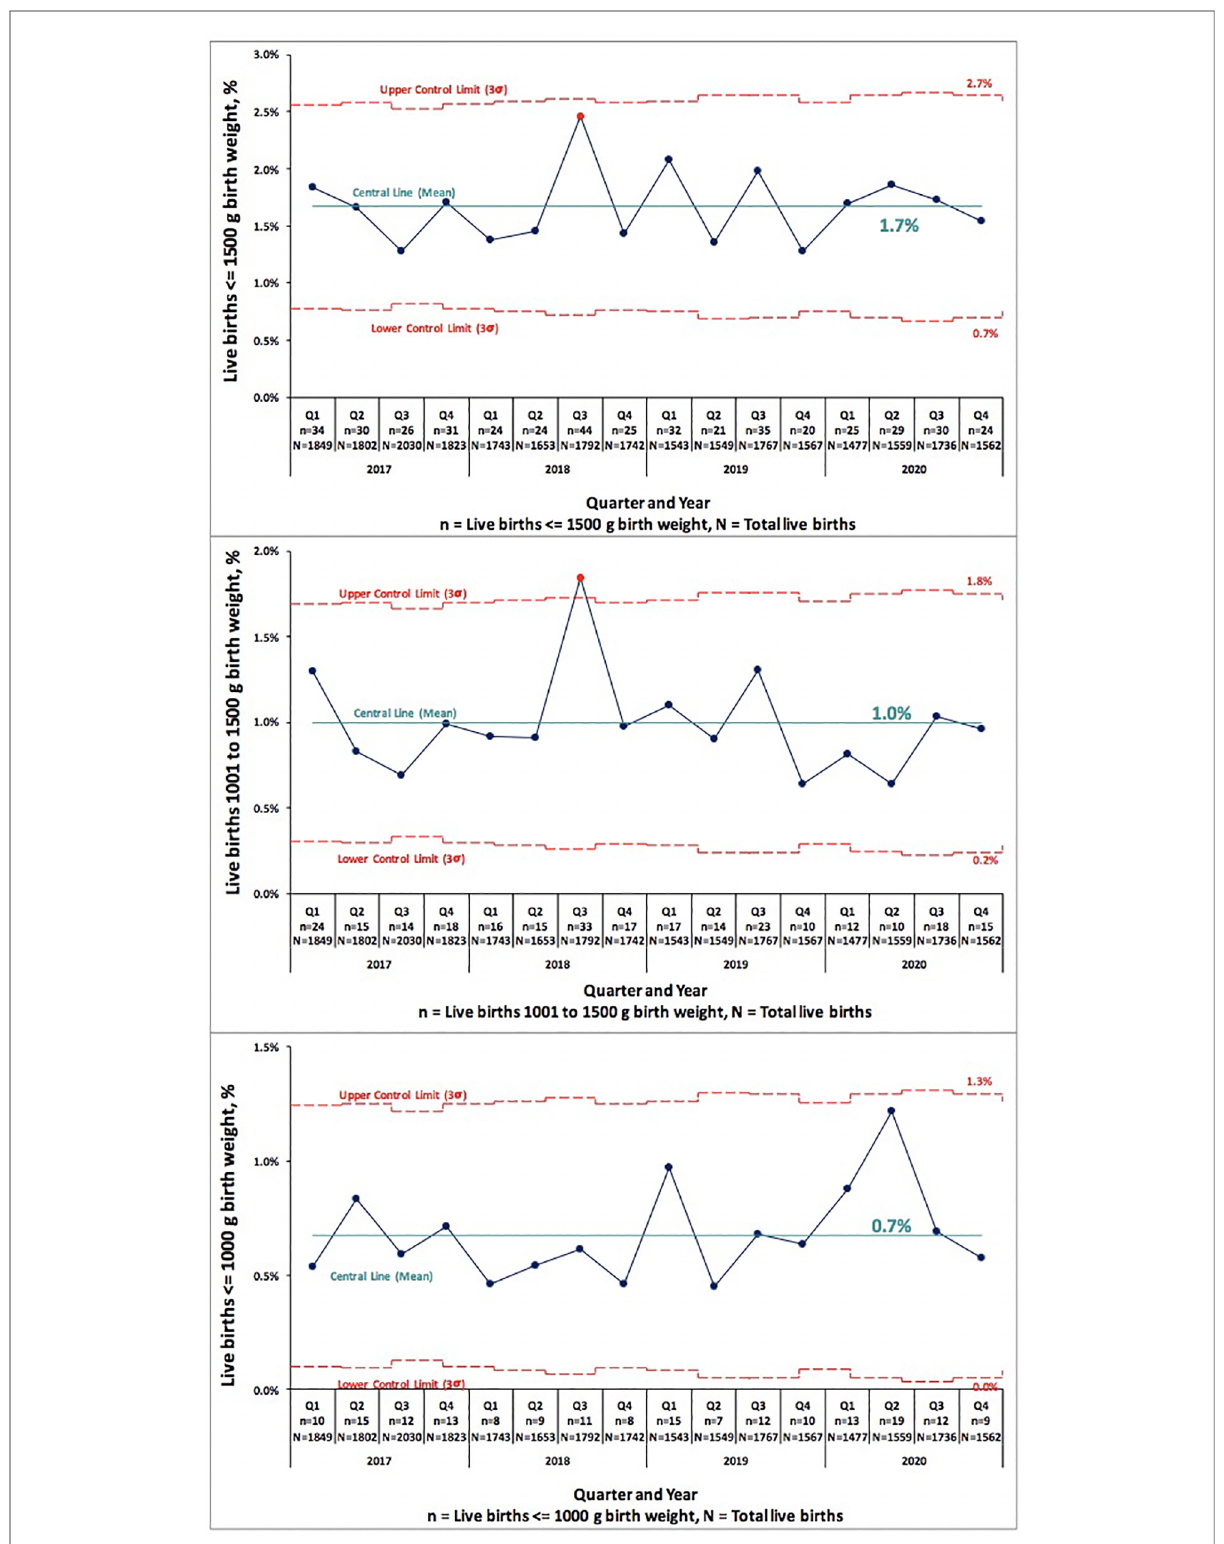
FIGURE 1 Pre-COVID-19 era (2017 – 2019) and COVID-19 era (2020) birth rates across fi ve medical centers strati fi ed by gestational age shown as statistical process control “ p ” chart. The central line represents mean and the upper and lower control limit lines are three standard deviations above and below